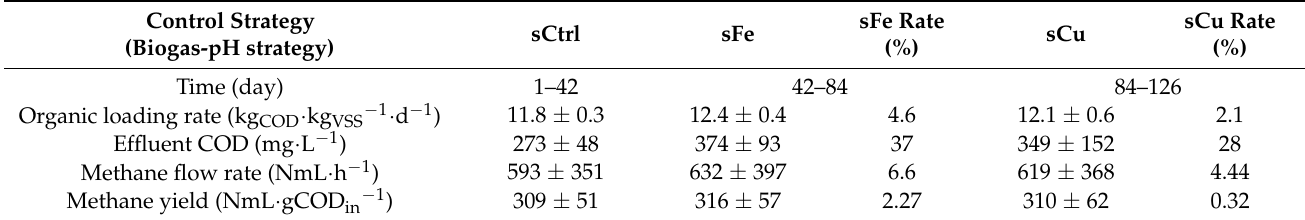
Figure 5. The influent and effluent COD of the anaerobic membrane bioreactor (AnMBR) without (sCtrl) augmentation and with ferric (sFe) and copper (sCu) augmentations at the Bayesian network meta-analysis-optimized dosages, respectively. The COD removal rate unexpectedly increased and met the discharging standard. Despite that, the methane yield with ferric augmentation in the long term was improved by 2.27%, just as predicted. Table 1. Changes of the methane yield and performance in a semicontinuous anaerobic membrane bioreactor (AnMBR). COD: chemical oxygen demand.